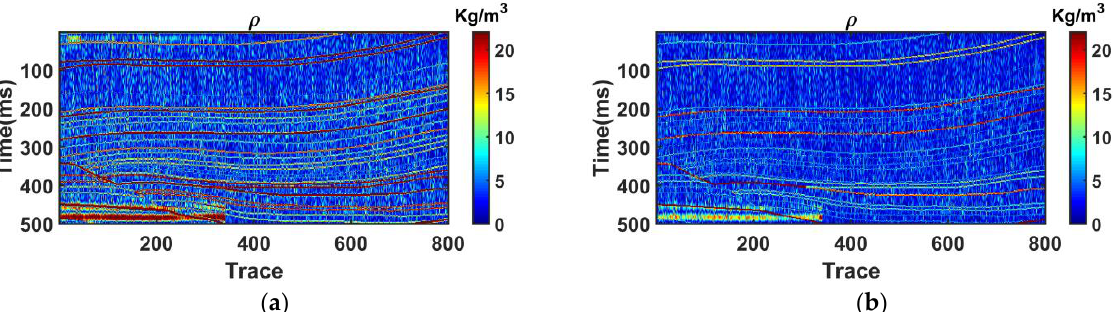
Figure 20. Density inversion error after adding noise based on ( a ) traditional method and ( b ) reweighted Lp method.